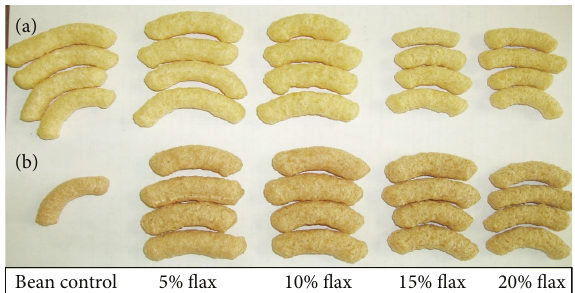
Figure 1: Extrudates obtained from combinations of navy (a)